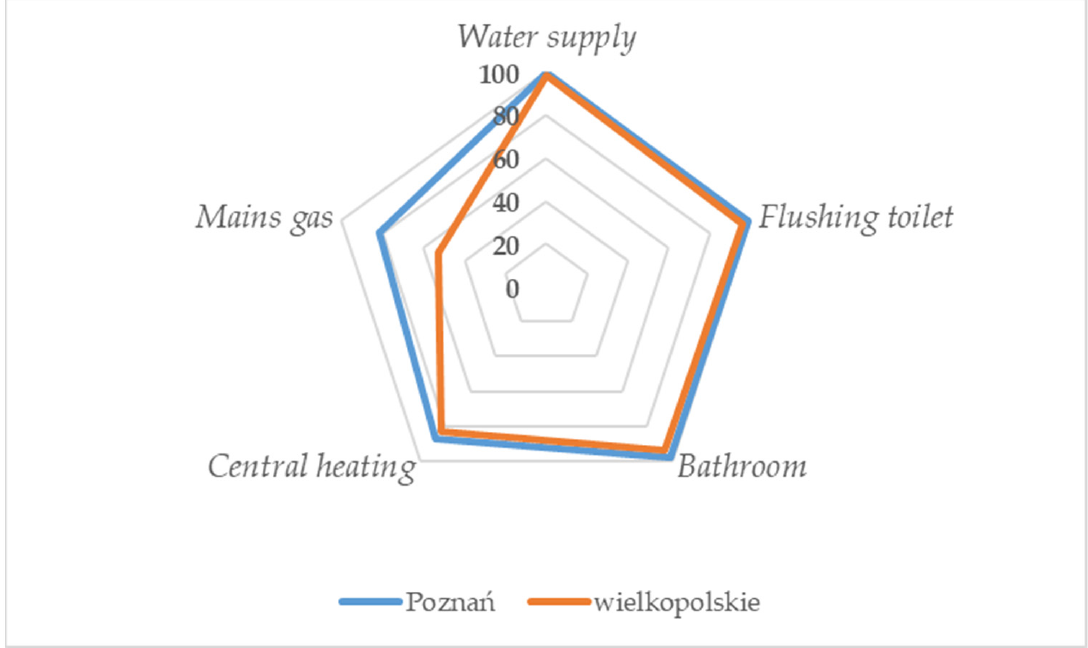
Figure 13. Indicators of housing infrastructure quality in Pozna ń and the Wielkopolska Province.